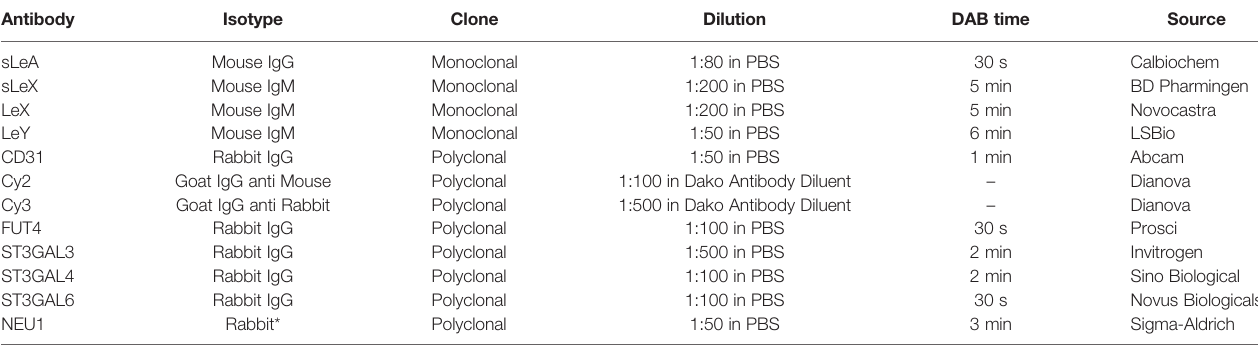
TABLE 2 | Antibodies used in this study.